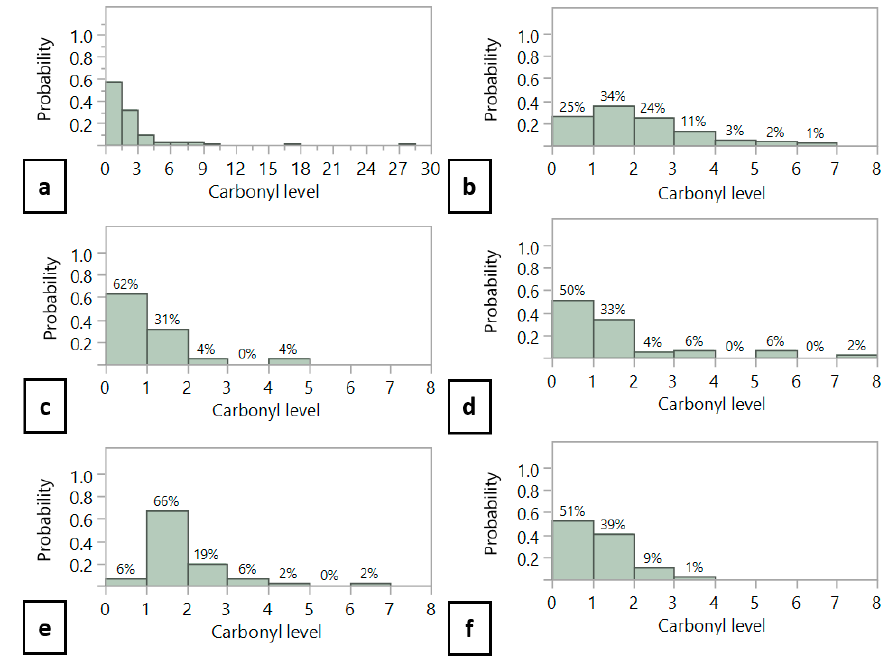
Figure 13. Probability of carbonyl levels in the bituminous zone: among all samples ( a ); GRA ( b ); GRAB Area 2 ( c ); GRAB Area 3 ( d ); MRAB ( e ); GRAR ( f ).